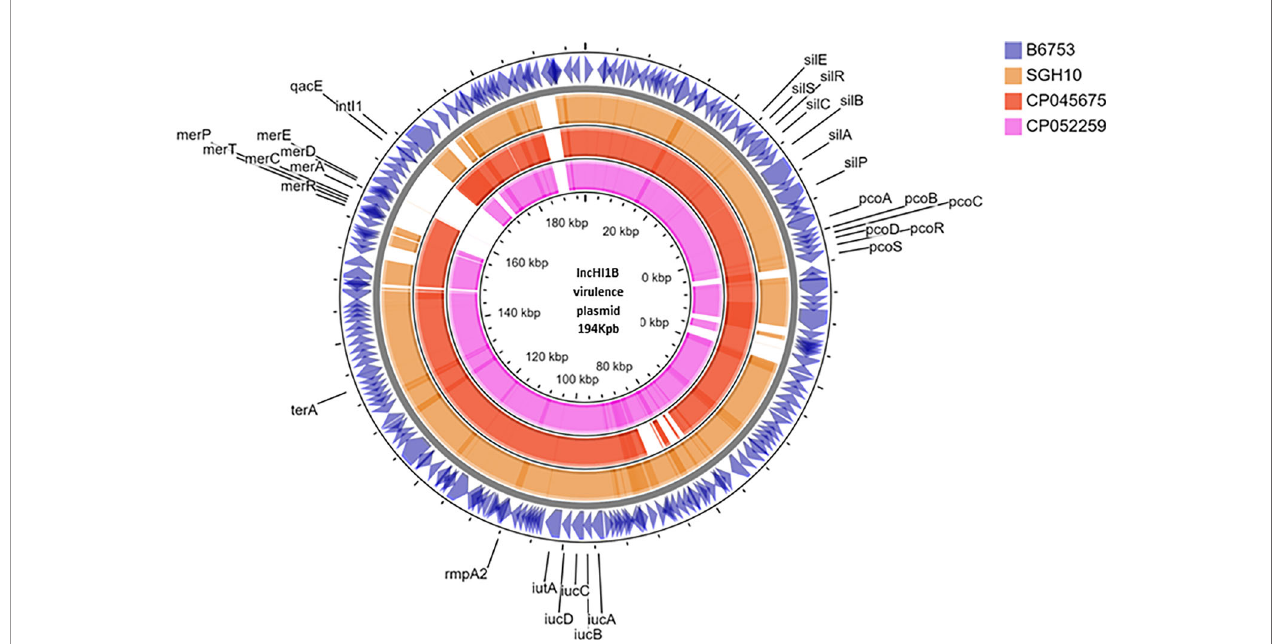
FIGURE 1 | Circular representation of virulence plasmid assembled from Kp B6753 displayed using CG view server. Comparison of virulence plasmid carrying rmpA2 among (1) Kp strain B6753 (CP067046) from ST43 (2) Kp strain SGH10 (CP025080) from ST23 (3) Kp strain WSD411 (CP045675) from ST15 (4) Kp strain E16KP0290 (CP052259) from